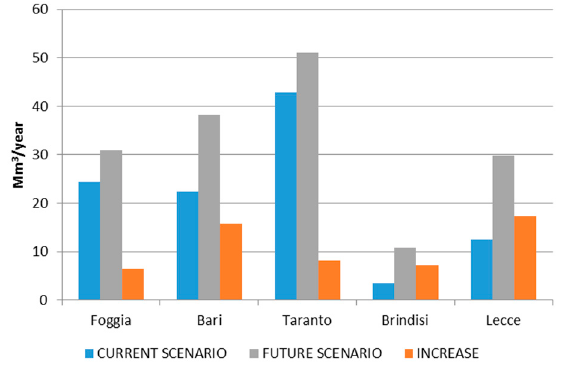
Figure 2. Reclaimed wastewater in Puglia.